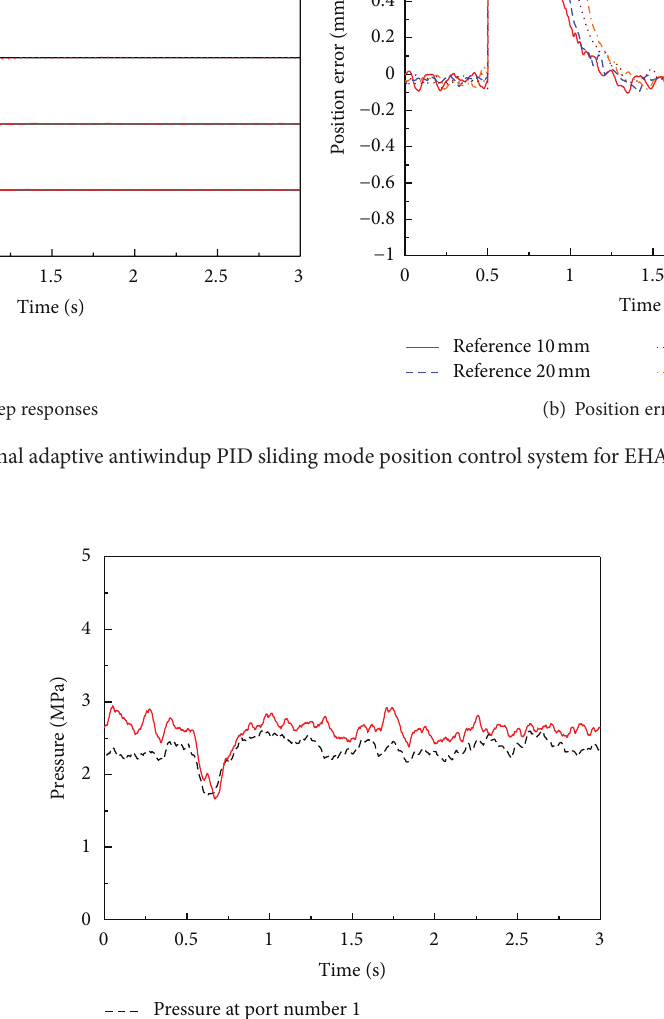
sliding mode control system. As shown in Figure 14